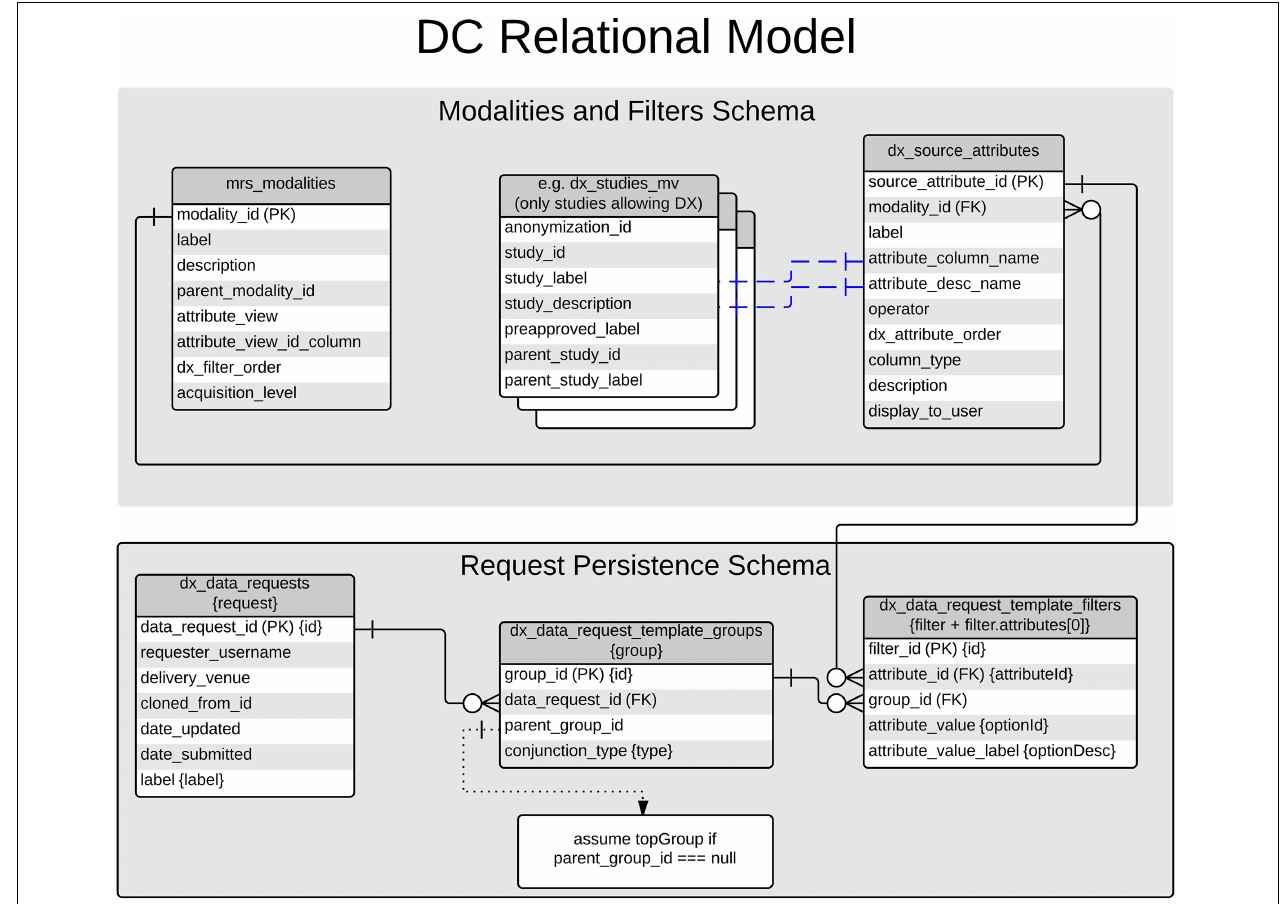
FIGURE 4 | Database schema for data